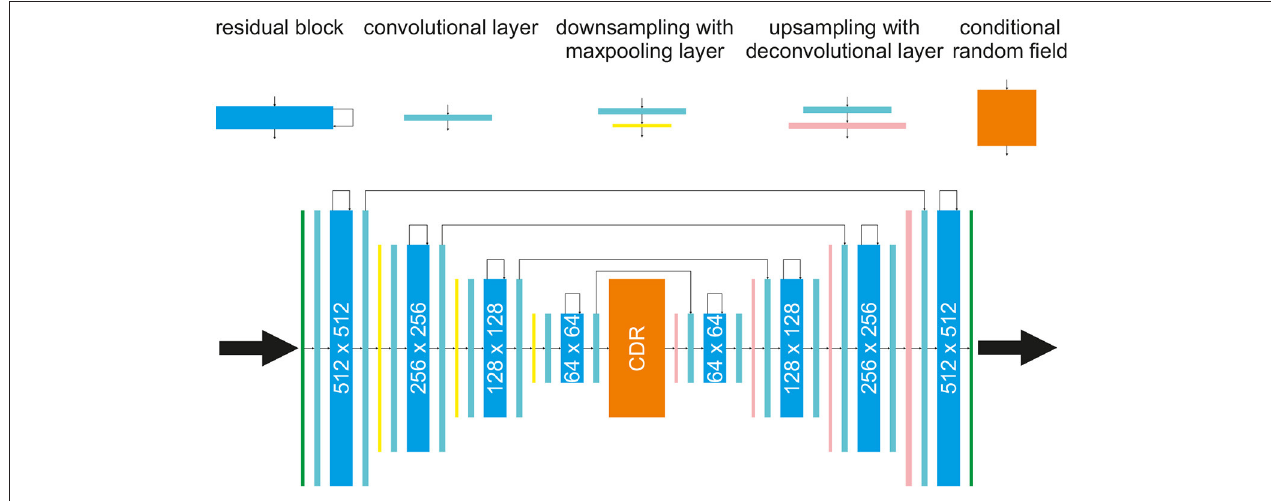
FIGURE 1 | The proposed architecture for forecasting and cross-estimation consisting of a splitted autoencoder and a conditional random field (CRF, orange block) in the middle, with residual blocks (cyan blocks), convolutional layers (turquoise blocks), maxpooling and downsampling layers (yellow blocks), and deconvolutional layers (pink